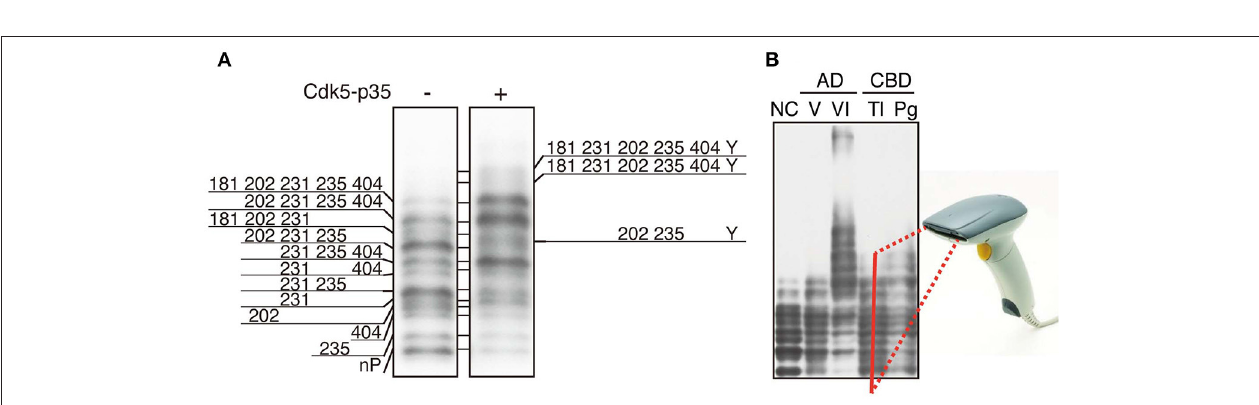
FIGURE 4 | Phosphoisotypes of tau on Phos-tag SDS-PAGE. (A) Immunoblotting of tau expressed in COS-7 cells with tau5 in the presence ( + ) or absence ( − ) of Cdk5-p35 after Phos-tag-SDS-PAGE, and the phosphorylation sites in each band are indicated by the amino acid number according to the human longest isoform of tau. Y is an unknown phosphorylation site. (B) Immunoblotting of tau in human brains after Phos-tag SDS-PAGE. NC, normal control; AD V and VI, Braak stage V and VI of Alzheimer’s disease (AD); CBD Tl and Pg, temporal lobe (Tl) and prefrontal gyrus (Pg) of corticobasal degeneration (CBD). We propose that the banding pattern created using Phos-tag SDS-PAGE could be read by a bar code reader and result in a simple method for diagnosing tauopathy. (A,B) are reproduced and modified from figures reported previously by Kimura et al. (2016a,b), respectively.